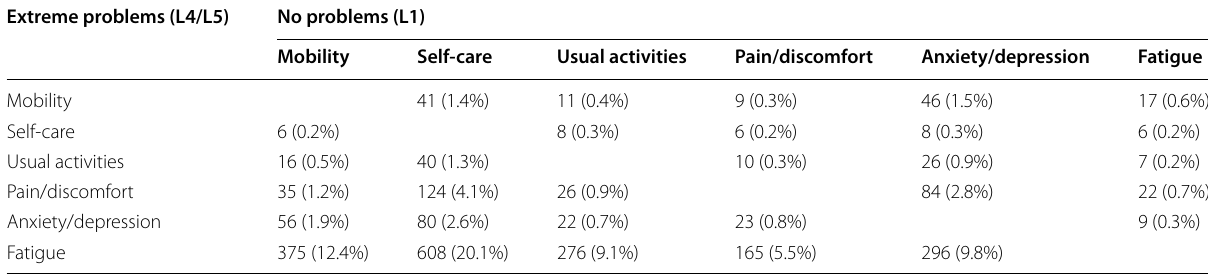
Table 4 Combinations of extreme values of the EQ-5D-5L expressed as the percentage of the total number of profiles